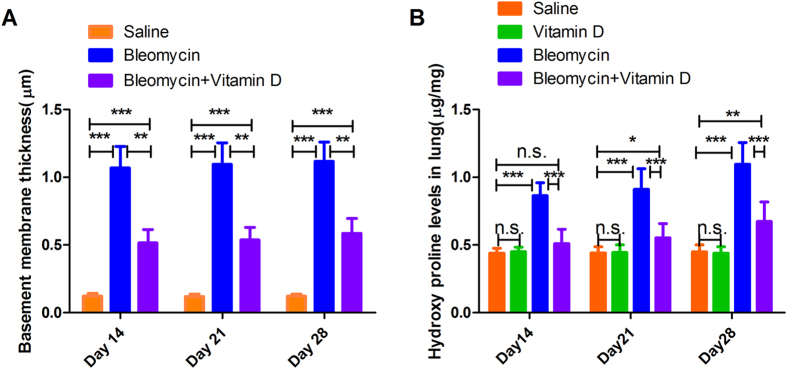
Effects of vitamin D treatment on pulmonary fibrosis.Vitamin D treatment partially reversed the basement membrane thickening induced by bleomycin (A). Vitamin D treatment significantly reduced the increase in hydroxyproline content induced by bleomycin, most profoundly on day 14 (B). Error bars = standard deviations, N = 6 for each group, n.s. (no significant) P > 0.05, *P < 0.05, **P < 0.01, ***P < 0.001.